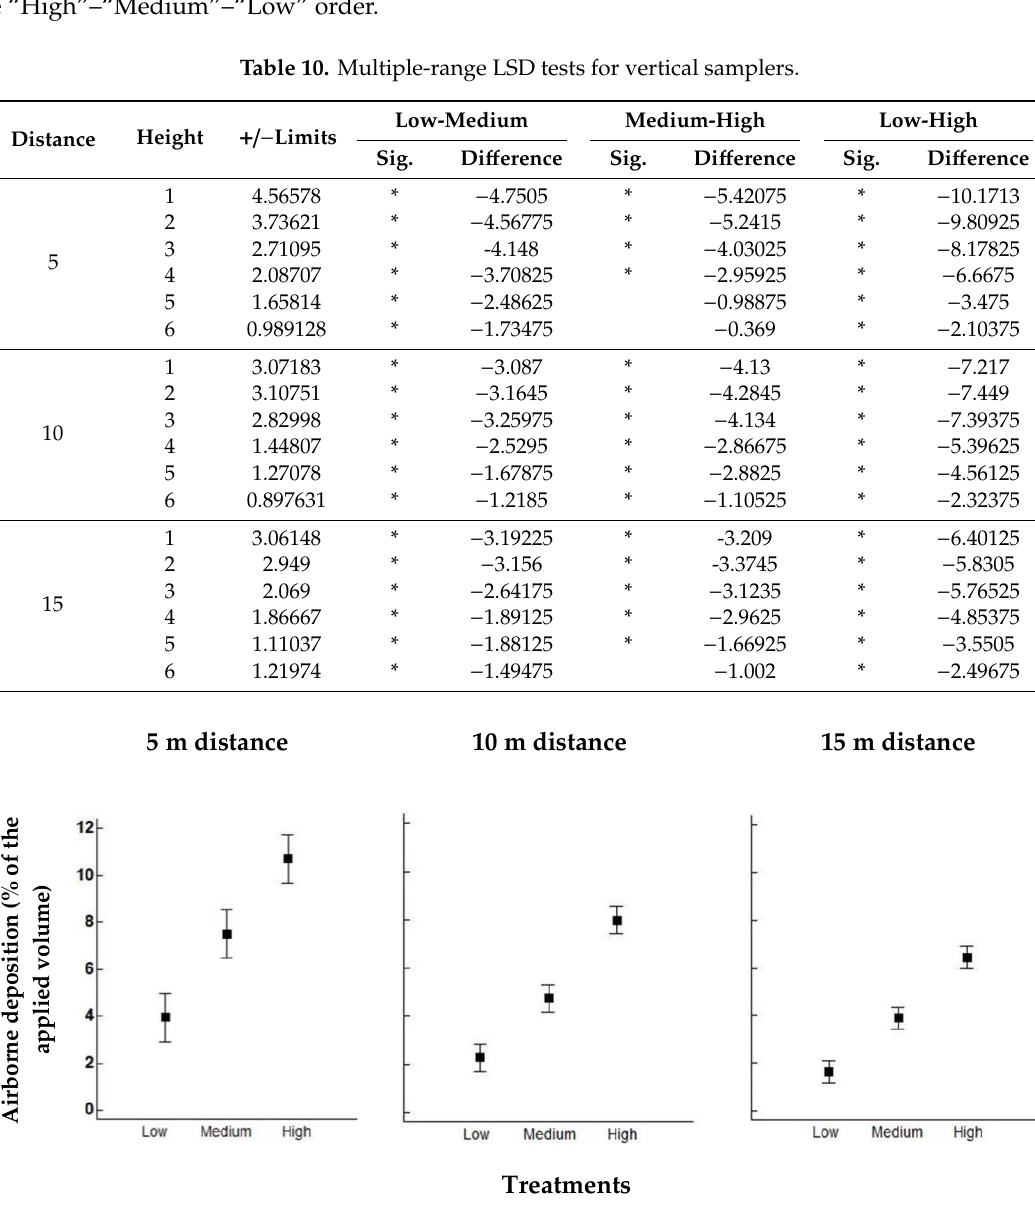
Figure 8. Airborne spray drift mean ± SE of the mean.